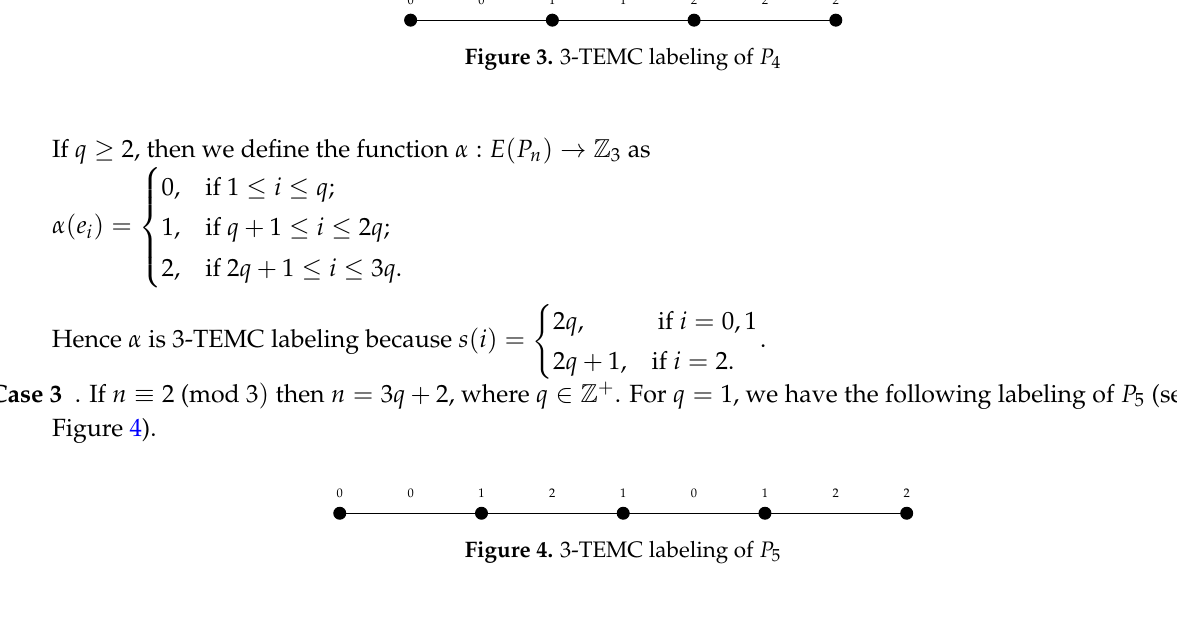
Figure 4. 3-TEMC labeling of P 5